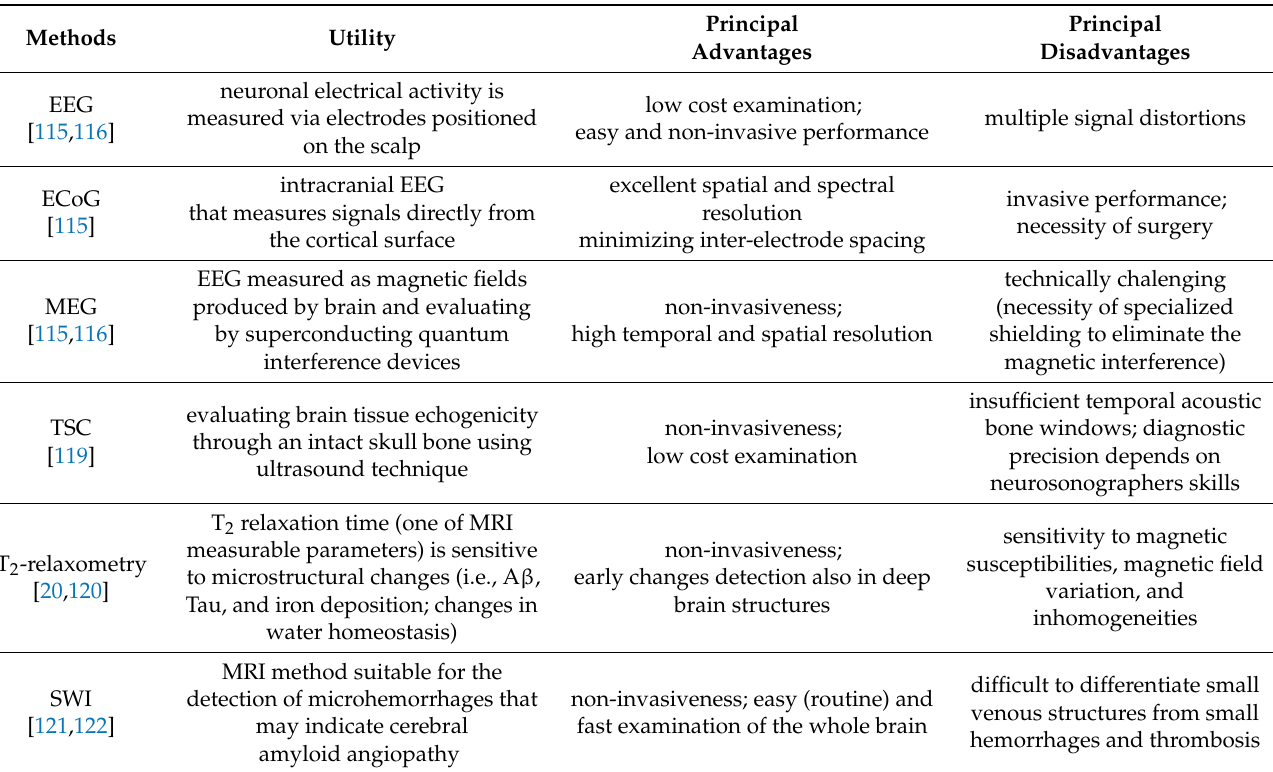
Table 2. The overview of non-common neurological examinations applicable for AD assessment.